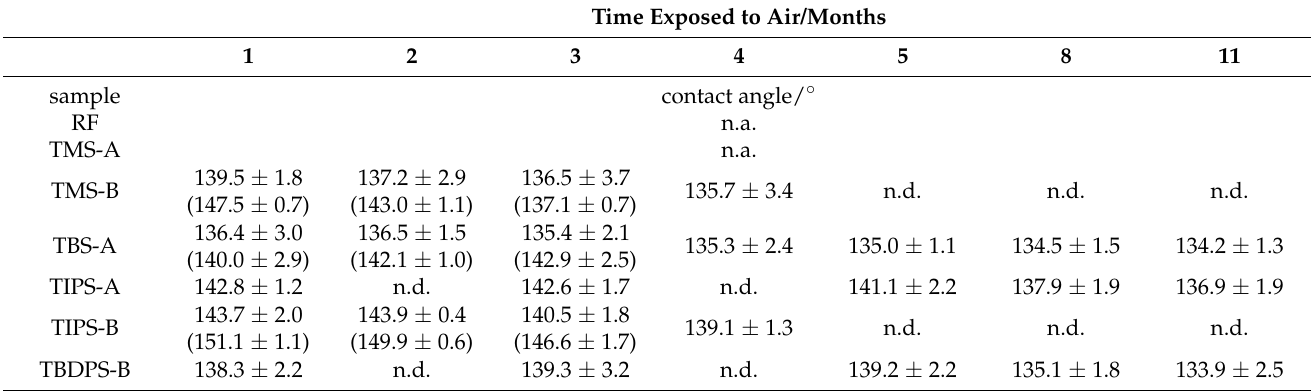
Table 3. Static contact angles, as determined using the tangent or the LB-ADSA (in brackets) method.